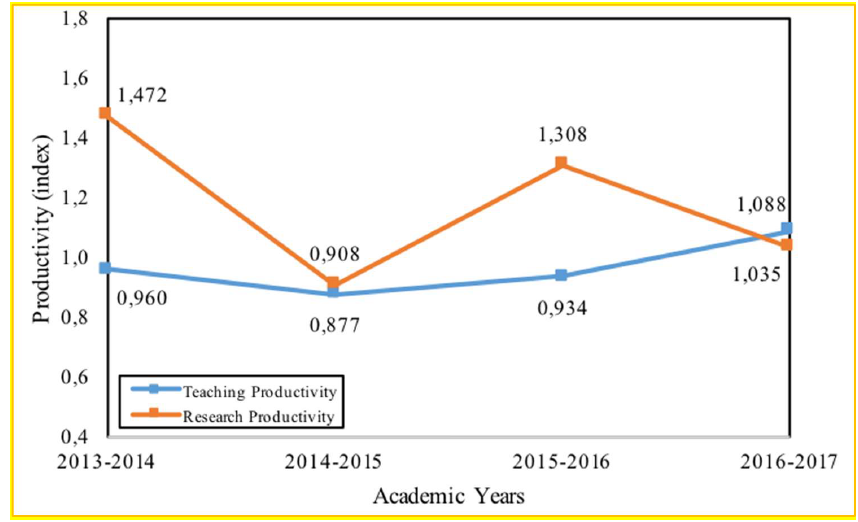
Fig. 1 . The Overview of Muhammadiyah Higher Education’s